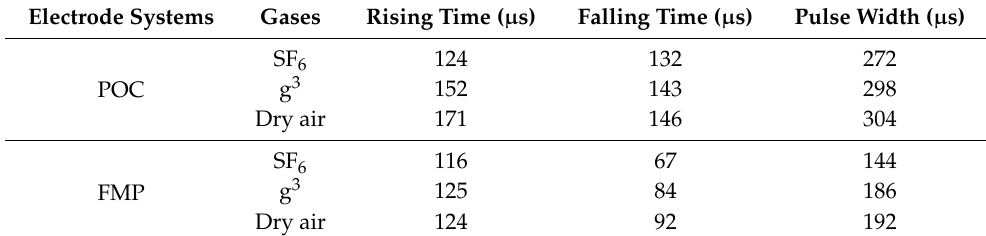
Figure 6. Typical single pulse and its fast Fourier transform (FFT) ( a ) in POC and ( b ) in FMP. Table 1. Parameters of each signal pulse according to the types of PD defect.